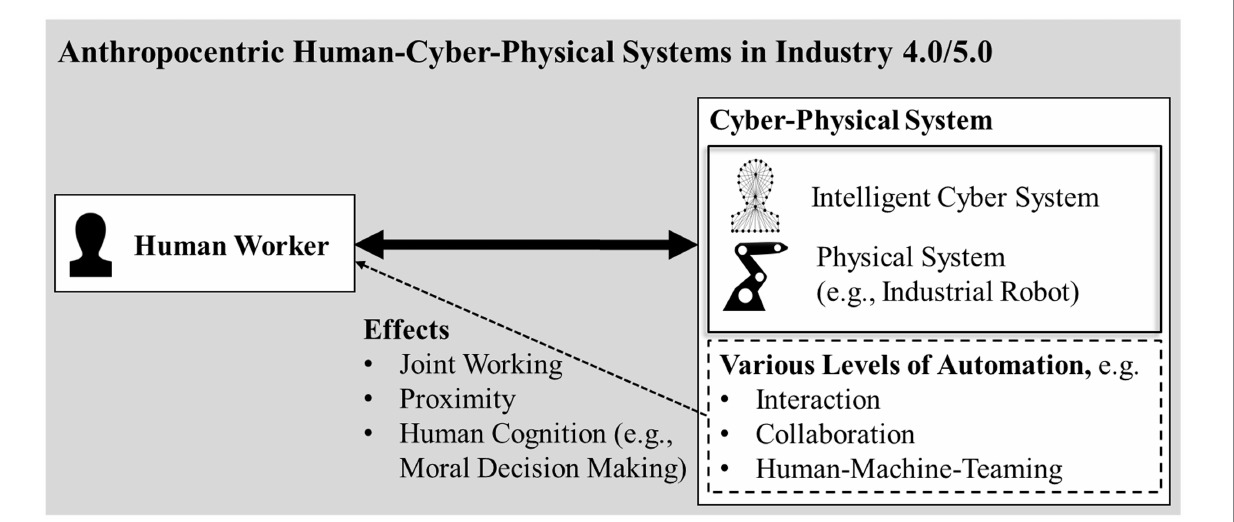
FIGURE 1 Anthropocentric human-cyber-physical systems in industry 4.0/5.0, exemplar level of automation and selected effects relevant for the presented